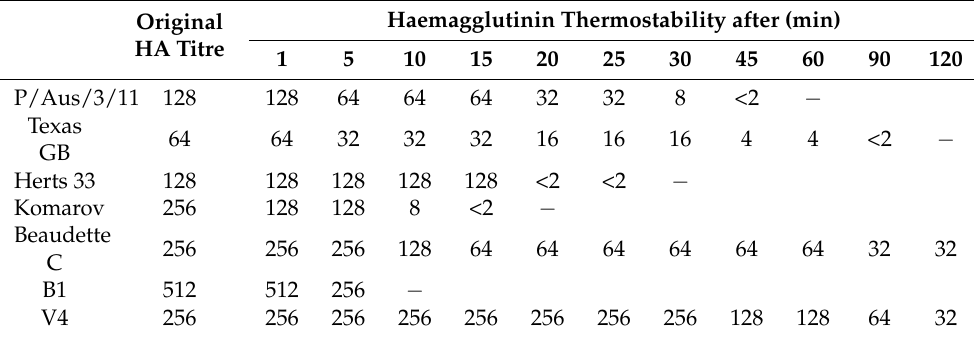
Table 4. HA thermostability of the P/Aus/3/11 isolate at 56 ◦